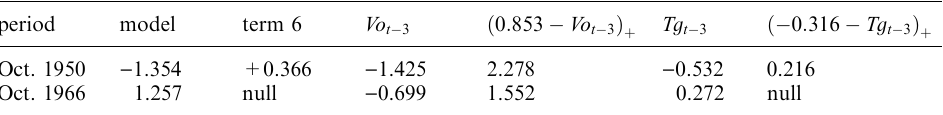
Table 4. A scheme describing the values assumed by para- meters and the contributions of sixth term and of the single